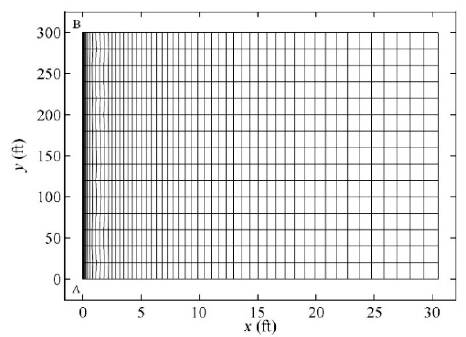
Figure 4. Schematic diagram of grid structure of numerical model.